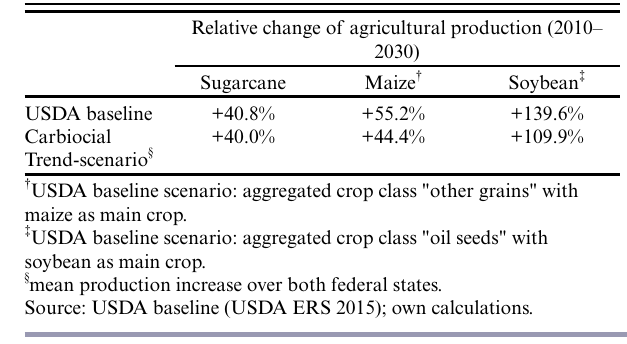
Table 1 . Comparison of the “Trend” scenario with the U.S. Department of Agriculture (USDA) baseline